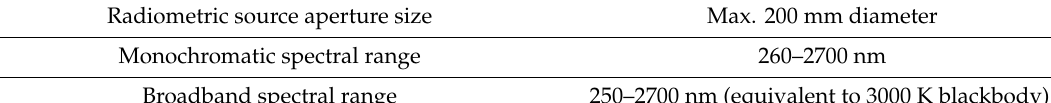
Table 5. Main radiometric specifications of the STAR-OGSE-CC.